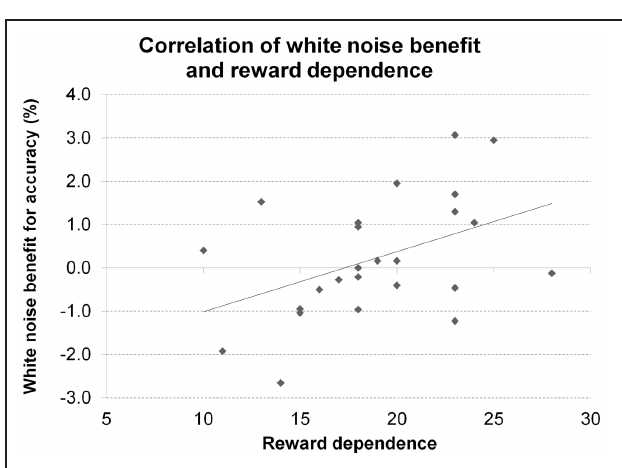
FIGURE 10 | Personality and performance in the Posner task. The figure depicts the correlation of reward dependence with white noise benefit for accuracy in Experiment